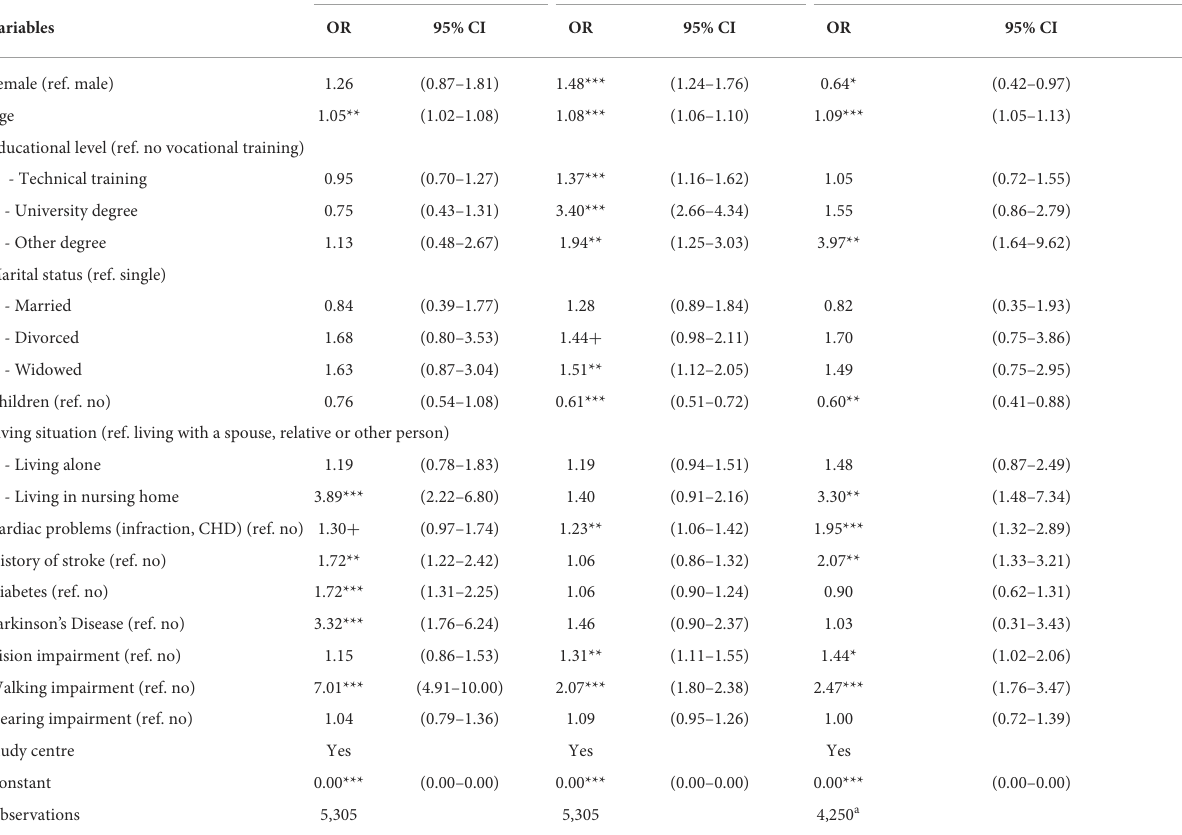
TABLE 2 Results of the multivariate logistic